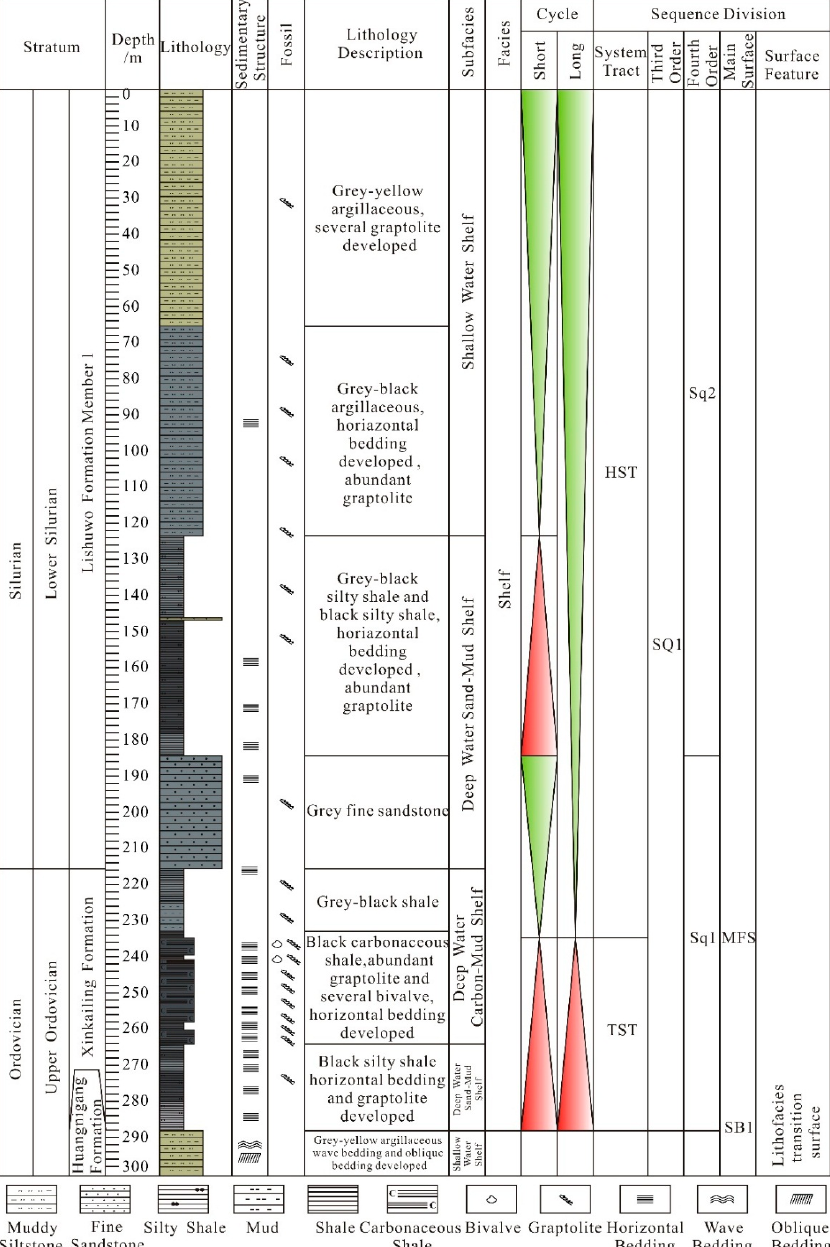
Figure 3. Xinkailing-Lishuwo formation sedimentary and stratigraphic section from PM1.